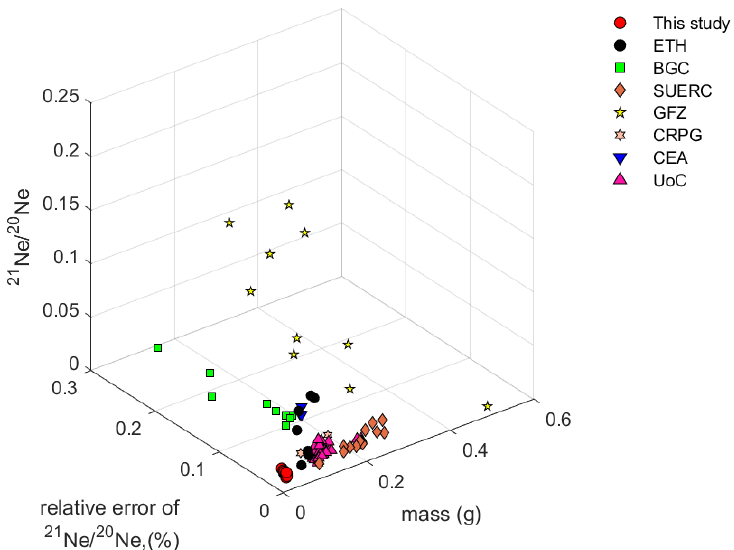
Figure 7. The error of 21 Ne/ 20 Ne from CREU-1 quartz with respect to the absolute isotope ratio value and amount of material analysed (mass) from a number of different laboratories. In theory, the relative error (1 σ ) should decrease with either increasing mass or increasing 21 Ne/ 20 Ne or the combination of both. No trend of this nature was observed, suggesting that other factors govern the relative error in the Ne isotope ratio of CREU. ETH (Switzerland), BGC (USA), SUERC (Scotland), GFZ (Germany), CRPG (France): CEA: China Earthquake Administration (PR China), UoC: University of Cologne (Germany). Data are from Refs. [5,24,25].